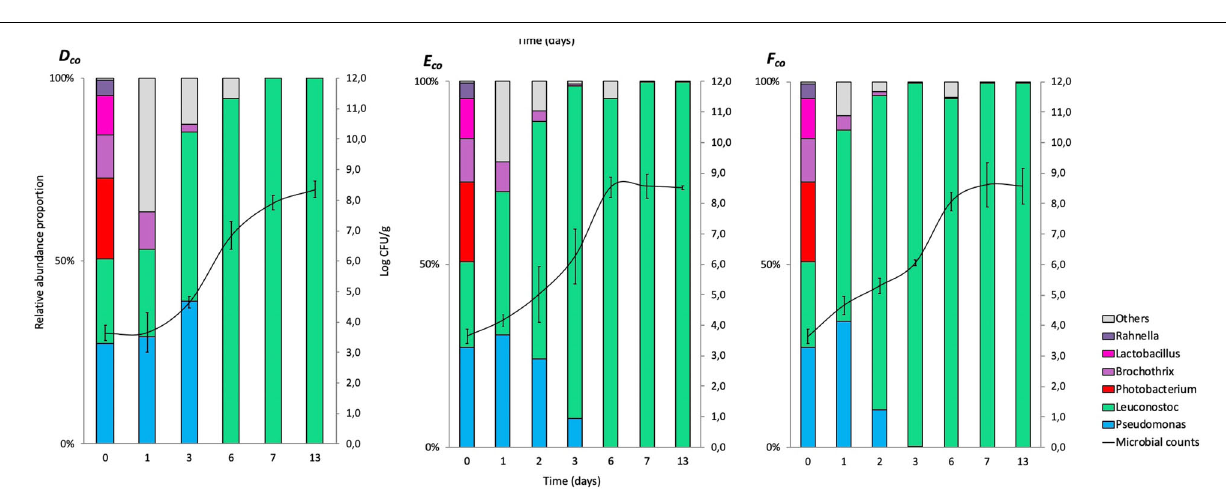
FIGURE 3 | Cumulated histograms of the relative abundance (%) of taxa and the dynamics of the bacterial community identified by metagenetics at genus levels in co-culture experiment during storage in modified atmosphere packaging ( D co , at 4 ◦ C; E co , at 8 ◦ C; F co , at 12 ◦ C). At genus levels, the taxa representing < 1% in relative abundance were merged in the category of “Others.” The solid represents the plate counts (means and standard deviation of the three